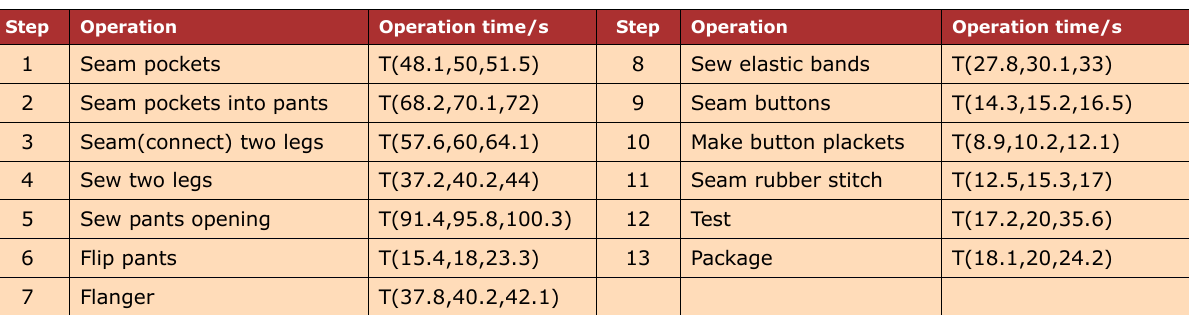
Table 1. Operation process and time measurement